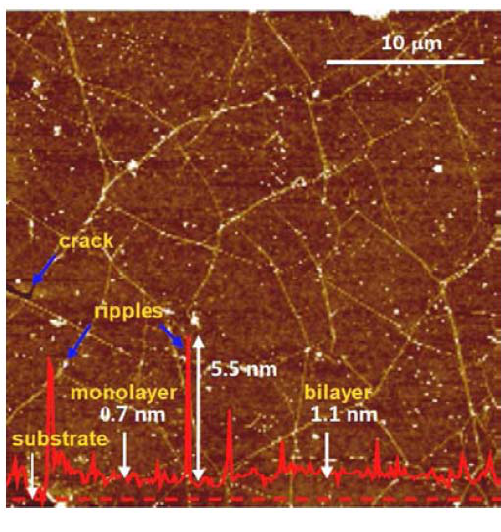
Figure 12. Atomic force microscope (AFM) image of a graphene film transferred onto a polyethylene terephthalate (PET) film using the thermal release tape. The solid red line is the height profile measured along the dashed red line. Reprinted with permission from